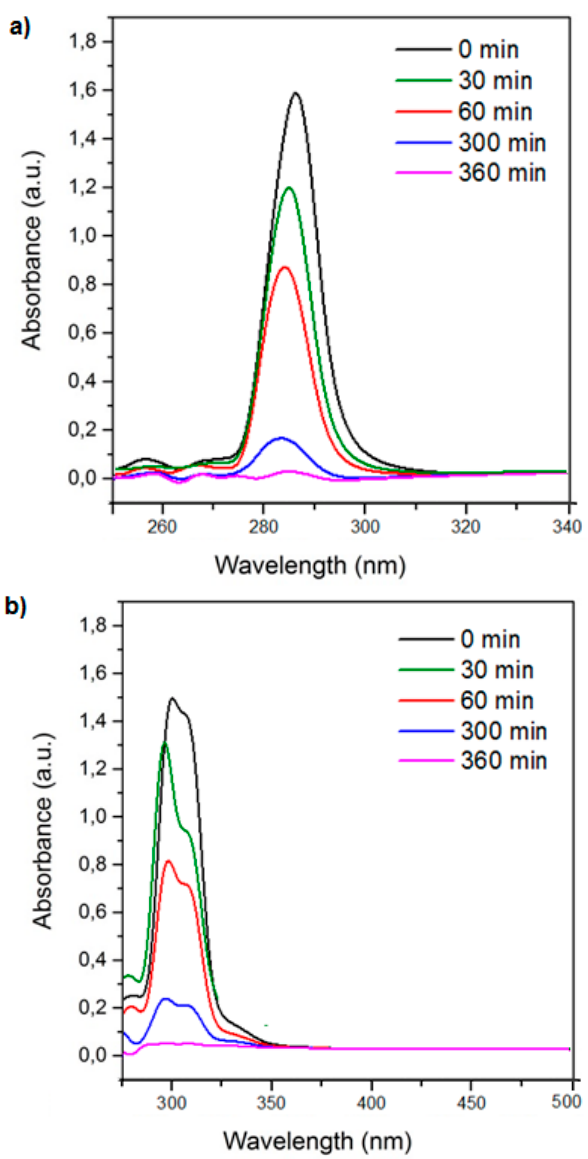
Figure 5. UV–VIS spectra for 4-chlorophenoxyacetic acid (4-CPA) ( a ) and 2,3,4,6-tetrachlorophenol (TCF) ( b ) at different contact times.